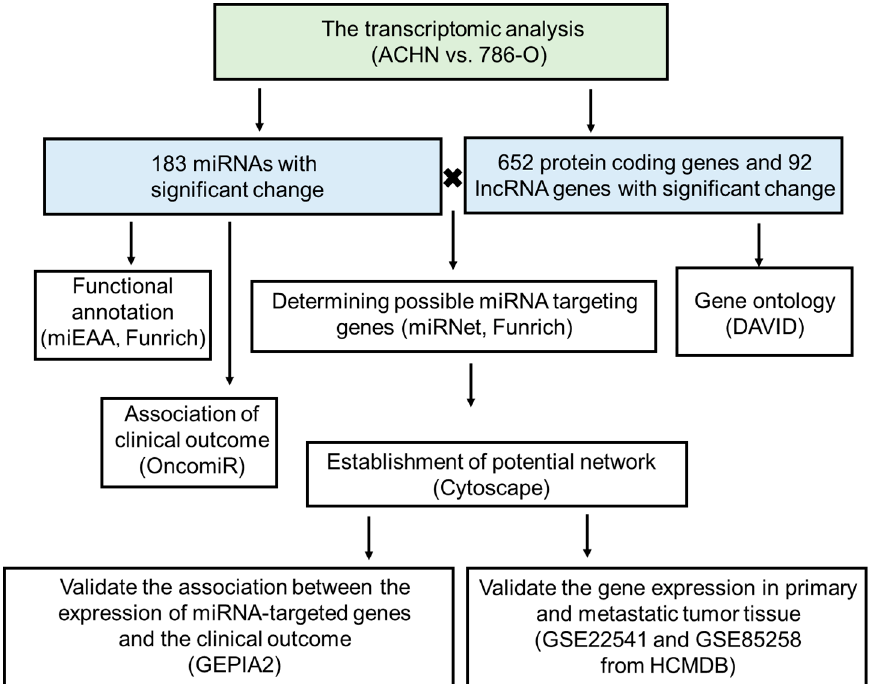
Figure 1. Flowchart of this study. The RNA of 786-O and ACHN cells were extracted and then subjected to RNA and small RNA sequencing. The differentially expressed 183 miRNA genes, 652 protein coding genes, and 92 lncRNA genes were identified. The functional annotation were performed via miRNet, Funrich, and DAVID. The possible miRNA targeting genes were predicted by miRNet and Funrich. The association of gene expression and survival rate was evaluated by OncomiR and GEPIA2. The expression in primary and metastatic tumor tissue via GEO datasets (the fold change and statistical analysis of GSE22541 and GSE85258 was adapted from